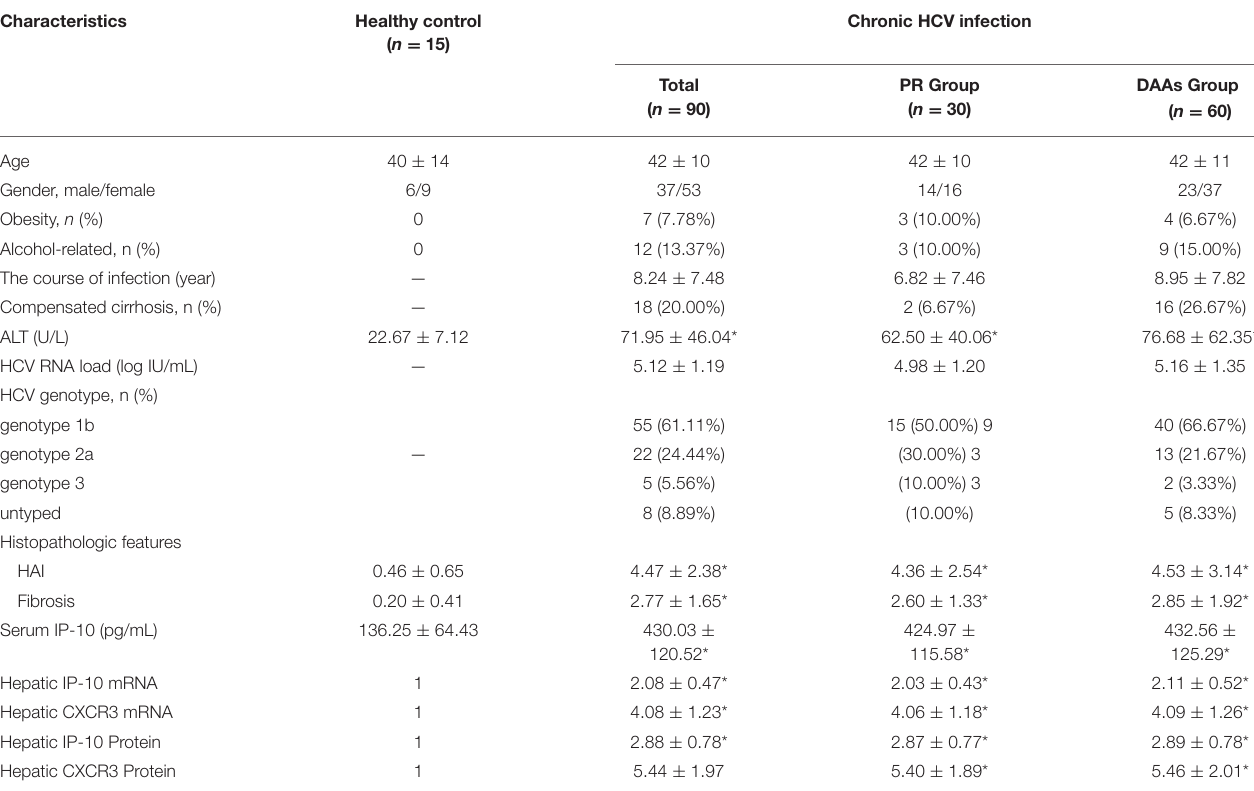
TABLE 1 | Demographic, serological, and hepatic histopathological characteristics. Characteristics